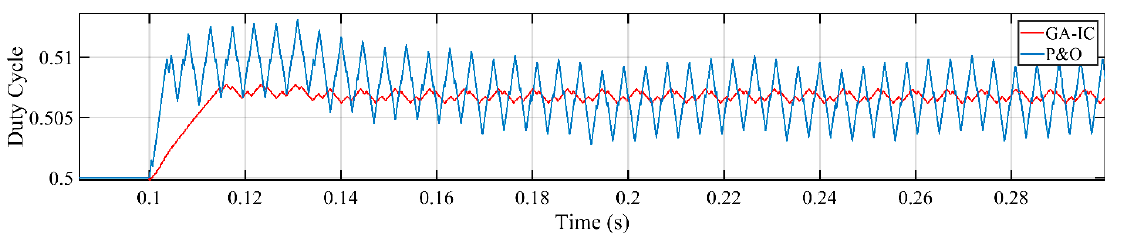
Figure 30. Case 3 duty cycle comparison of modified GA-IC vs. P&O.